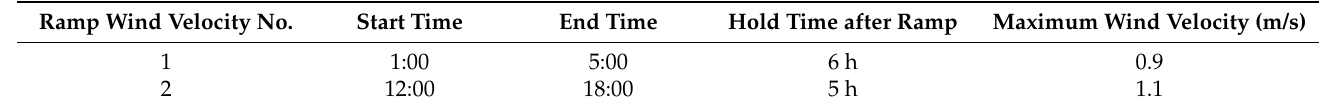
Table A7. Parameters of the ramp wind velocity in Scenario II in the case study. Ramp Wind Velocity No.